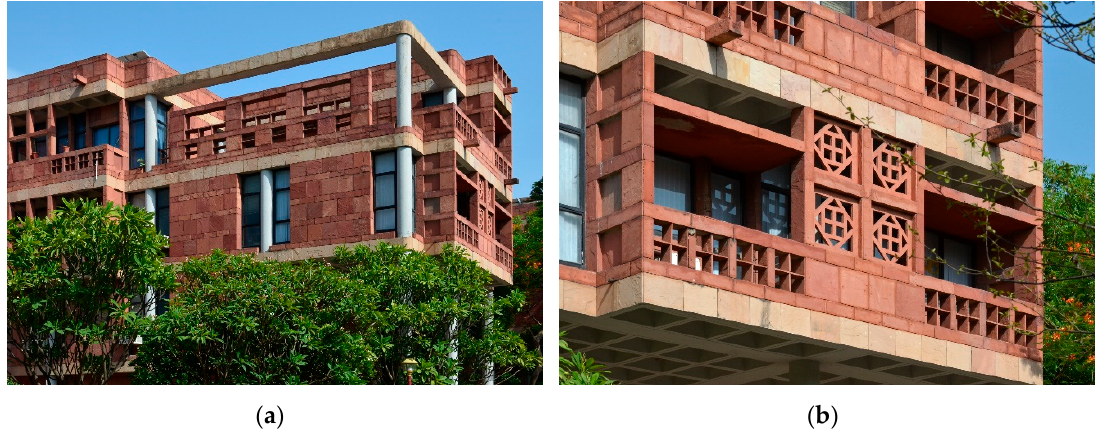
Figure 10. ( a ) Sandstone clad external skin delays heat transfer into the CIET building; ( b ) balconies and jaali screens protect the rooms of the CIET building from direct sun (Photos: Author).